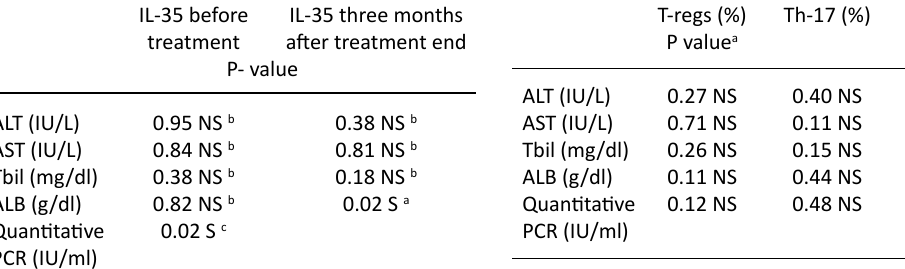
table 3. Correlation between IL-35 and laboratory work-up IL-35 before